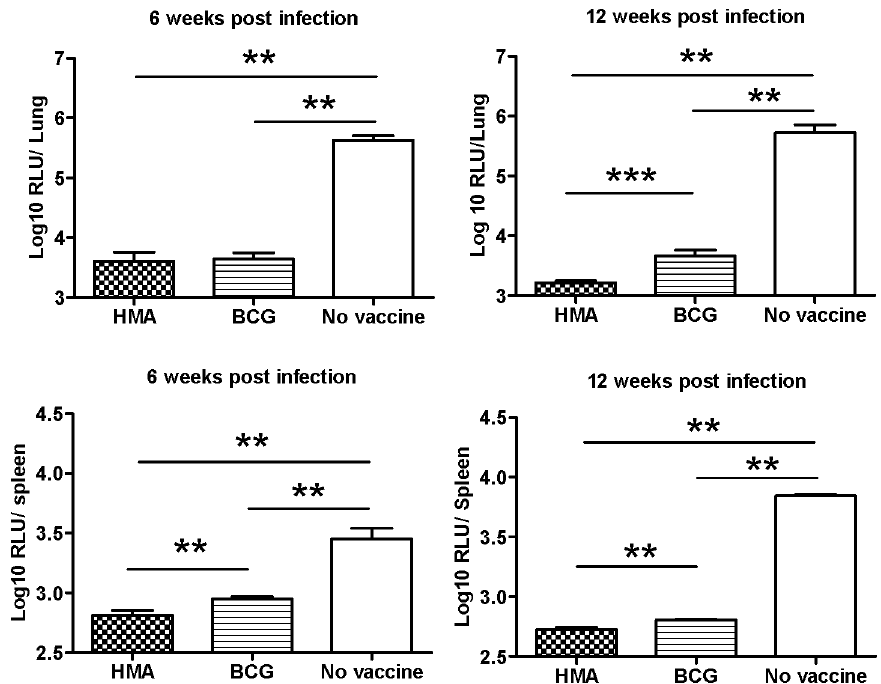
Figure 8. Bacterial replication in lungs and spleen of BALB/c mice vaccinated with HMA or BCG and challenged with 10 5 CFU of virulent luminescent M. tuberculosis . Mean number of bacteria in lungs and spleen of BALB/c mice vaccinated with 5x10 5 CFU of HMA mutant or BCG or unvaccinated mice (naïve), challenged 12 weeks later with 10 5 CFU of virulent M.tb by the intratracheal route and sacrificed 6 or 12 weeks after challenge. Results are reported as mean log 5 mice tested individually; ** P <0,01; *** P <0.001 (Mann-Whitney test).